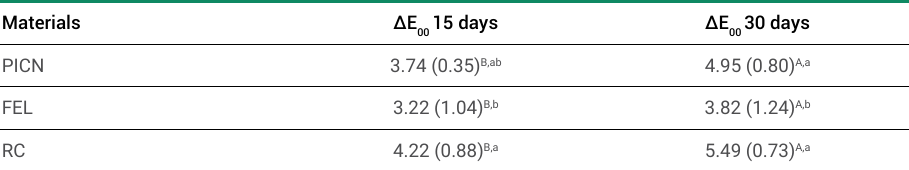
Table 3. Means (standard deviations) of color difference (∆E staining in red wine. Materials